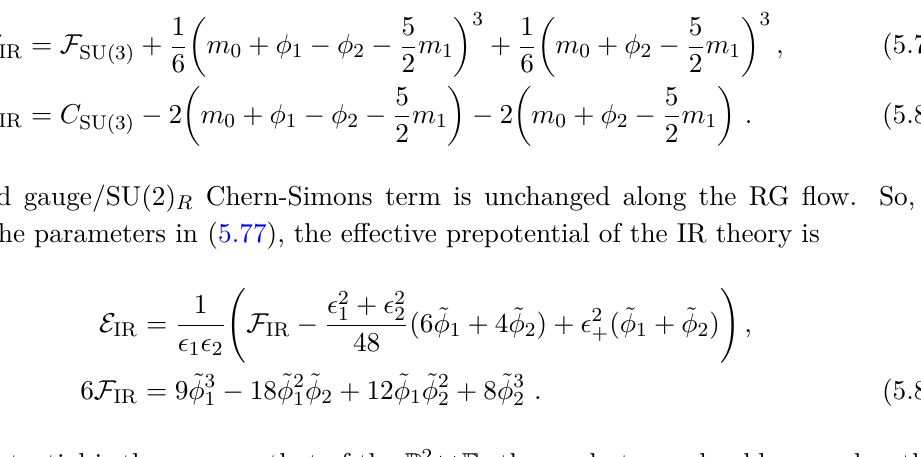
Figure 6. A 5-brane web for SU(3) φ 2 − 5 m 1 and m 0 + φ 2 − 5 2